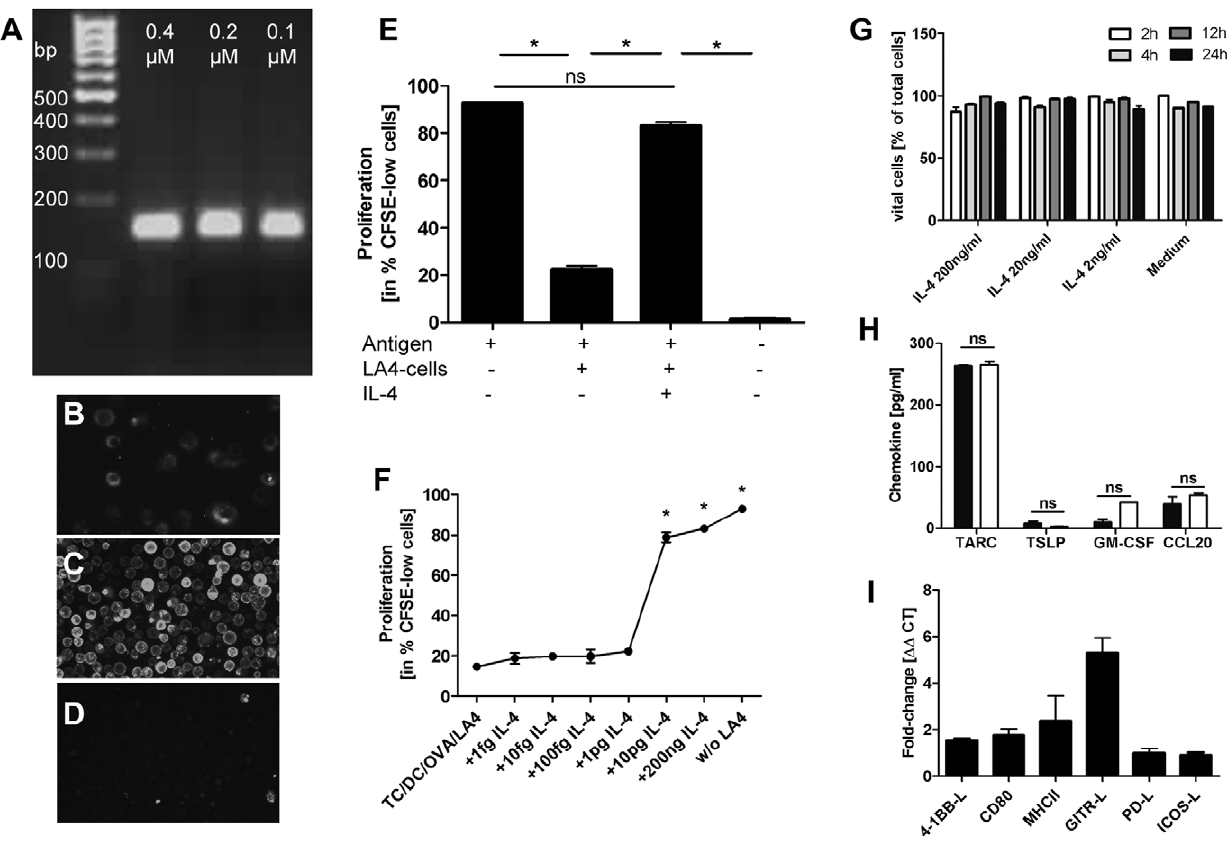
Figure 4. Suppression of T cell proliferation by airway epithelial cells is attenuated by IL-4. Proliferation of OVA-specific DO11.10 T cells was induced by DC-mediated OVA-presentation. Cultures w/o antigen served as controls. Epithelial-mediated suppression was assessed in co-culture with the LA4-cell line, a murine, type II pneumocyte cell line which was pre-treated with the indicated doses of IL-4 (F,G) or pre-treated with 200ng (E) or 10pg of IL-4 (H + I). Harvests were performed on day 4 of co-culture (E + F) or 24 h after IL-4 treatment (H + I). A: mRNA expression of IL-4R a on untreated LA4 cells, shown are products obtained with different primer concentrations. B: Assessment of IL-4R a surface expression via immunofluorescence microscopy of untreated LA4 cells, C: Corresponding IL-4R a surface expression on splenocytes cultured with 1 m g ConA for 3d, D: Corresponding isotype control antibody. E: Pre-treatment with IL-4 (200 ng) reduces epithelial mediated suppression of T cell proliferation on day 4 of co-culture. F: Attenuation of epithelial-dependent suppression of T cell proliferation by IL-4 is dose-dependent. A culture without LA-4 cells (w/o) and IL-4 served as control. G: IL-4 treatment for 2–24 h at the indicated doses does not influence viability of LA4 cells, measured by trypan blue exclusion. H: IL-4-treatment of epithelial cells (10 pg; white) does not change epithelial cytokine secretion (black). I: IL-4 induces GITR-L expression in epithelial cells. TC = T cell, DC = dendritic cell. *p , 0.05 compared to all other variables tested or as designated by bars, calculated by Mann- Whitney-U test. Representative experiments of